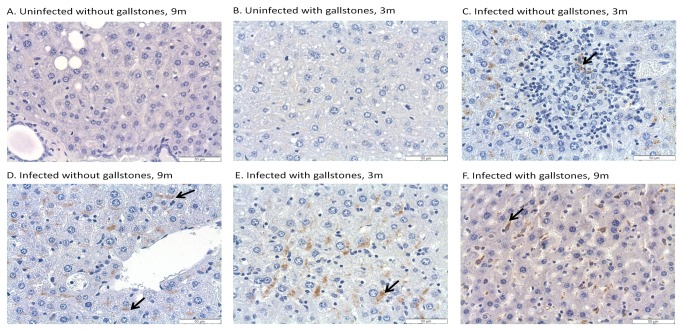

Salmonella LPS staining was detected in the liver regardless of the presence of gallstones.Representative IHC images of mouse liver sections at 3 and 9 months post-infection using an anti-Salmonella LPS antibody. Panel C shows a typhoid nodule. Black arrows indicate the presence of Salmonella inside inflammatory macrophages (Panel C) or Kupffer cells (Panel F) or intracellularly in hepatocytes (Panels D, E). DAB and hematoxylin counterstain. 40x.